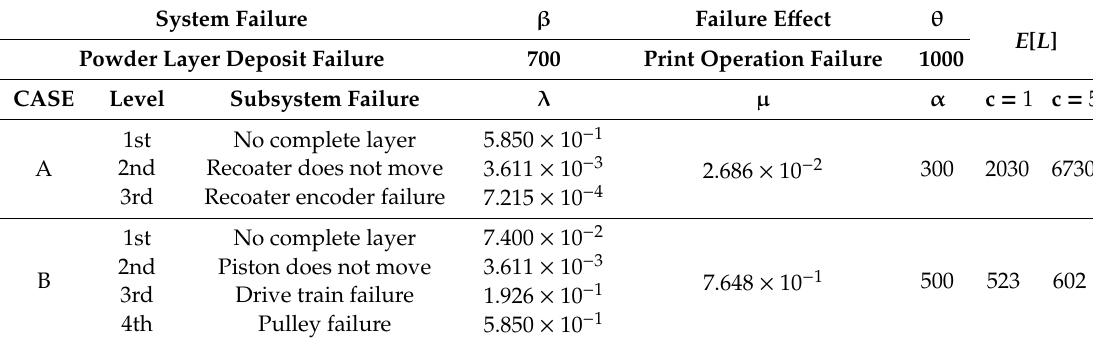
Table 1. HTD-FMEA sheet from the example in Figure